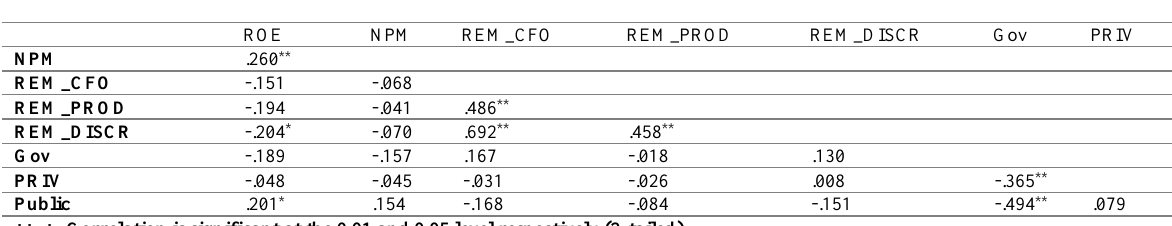
Table 2: Pearson Correlation Test